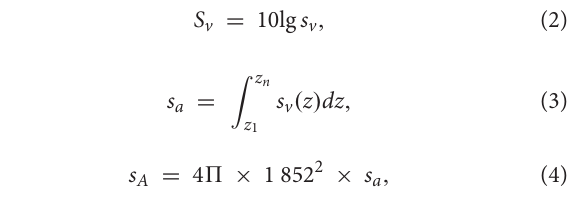
Frontiers in Marine Science |